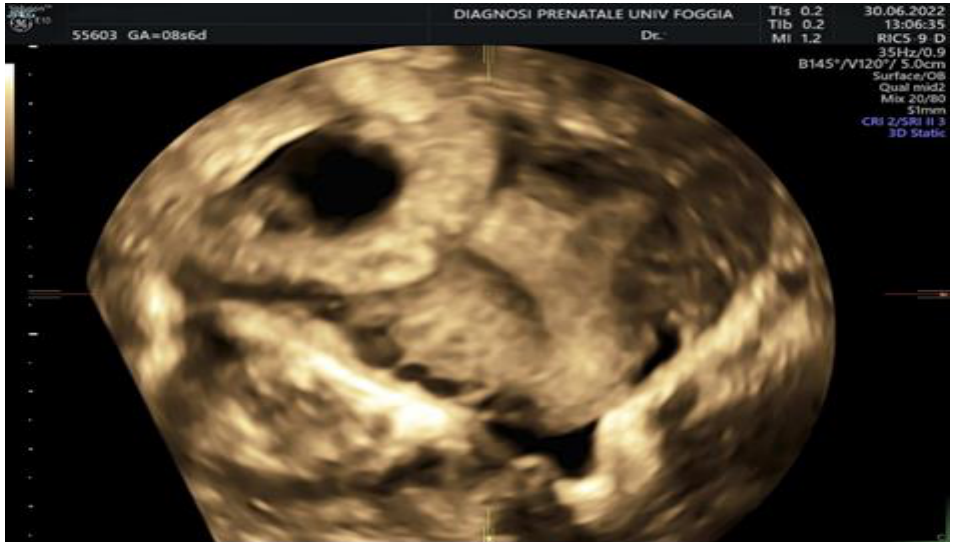
Figure 7. 3D transvaginal ultrasound scan performed on day 15 showing the interstitial pregnancy.